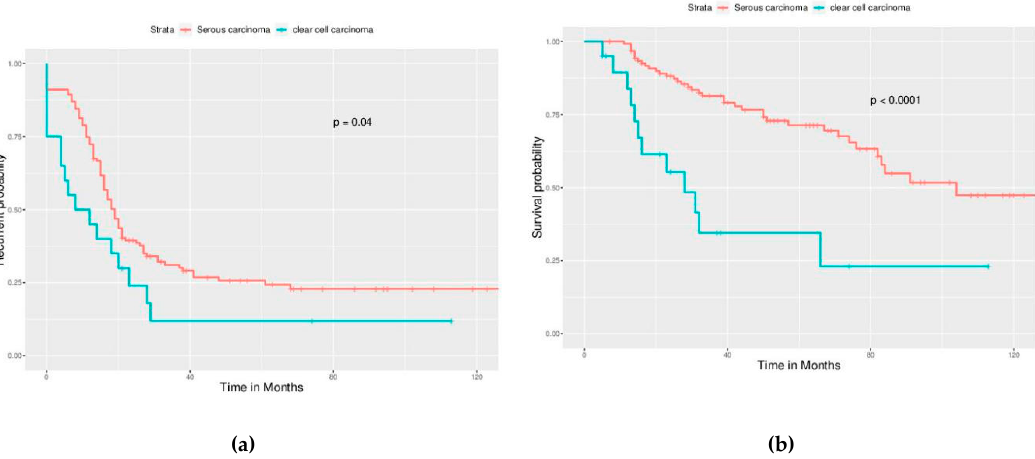
Figure 3. Survival curves by cell type (All enrolled cases), focus on serous type, and clear cell type. ( a ) PFS, p = 0.04, ( b ) OS, p < 0.0001. The outcome of clear cell carcinoma is worse than serous carcinoma.